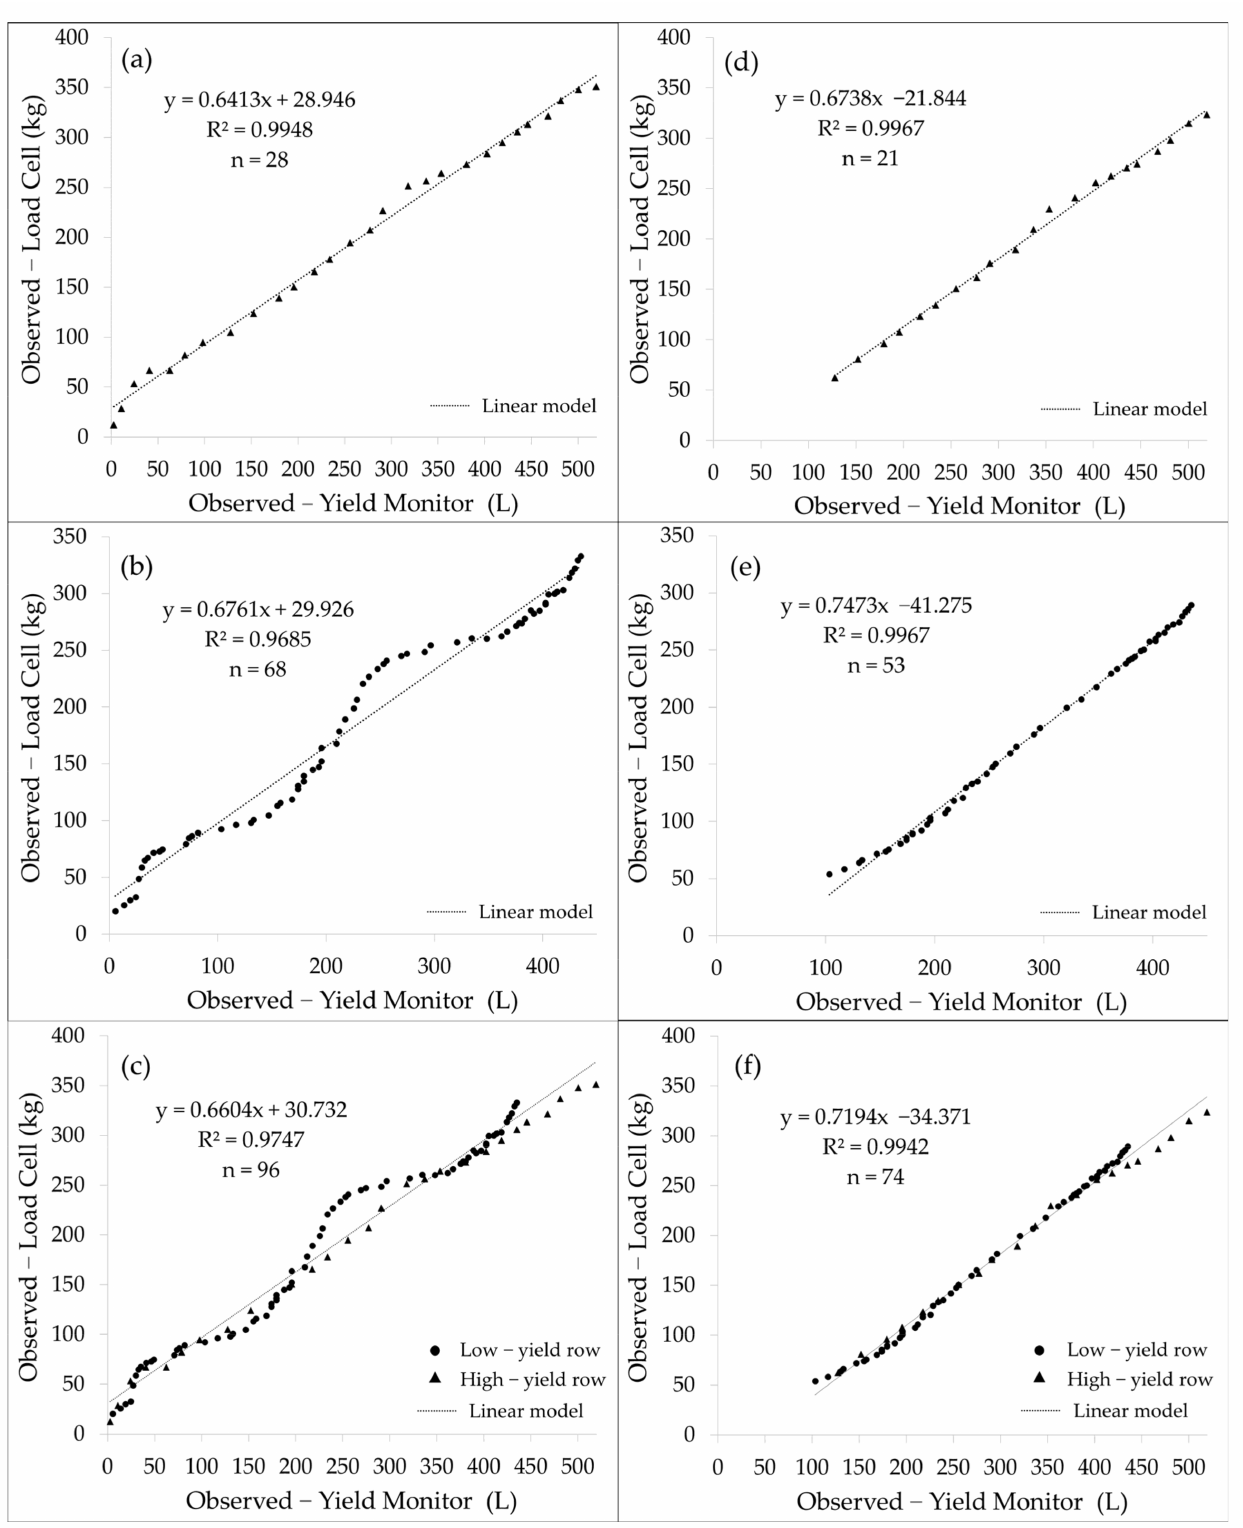
Figure 5. Linear regression of coffee harvest data obtained by the yield monitor and by load cells for the ( a , d ) high-yield row, ( b , e ) low-yield row, ( c , f ) and all data together ( a – c ) before and ( d – f ) after correcting the